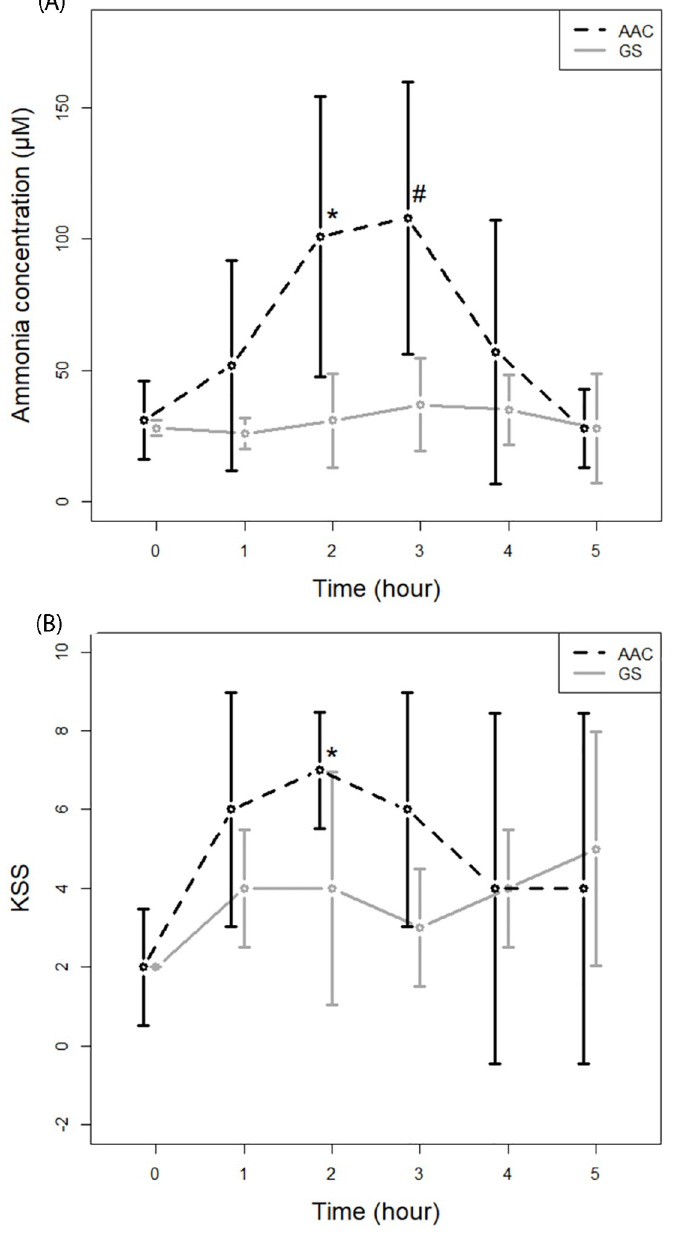
Fig 4. A. Capillary ammonia concentration during the two experimental days. Capillary ammonia concentrations ( μ M) at baseline, 1, 2, 3, 4, and 5 hours after intervention with either an amino acid challenge (AAC) or equicaloric glucose solution (GS). � ) Significantly different from GS (p = 0.0156, paired Wilcoxon signed-rank test). #) Significantly different from GS (p = 0.0223). B. Karolinska sleepiness score during the two experimental days. Karolinska sleepiness score (KSS) at baseline, 1, 2, 3, 4, and 5 hours after intervention with either an amino acid challenge (AAC) or equicaloric glucose solution (GS). � ) Significantly different from GS (p = 0.0120, paired Wilcoxon signed-rank